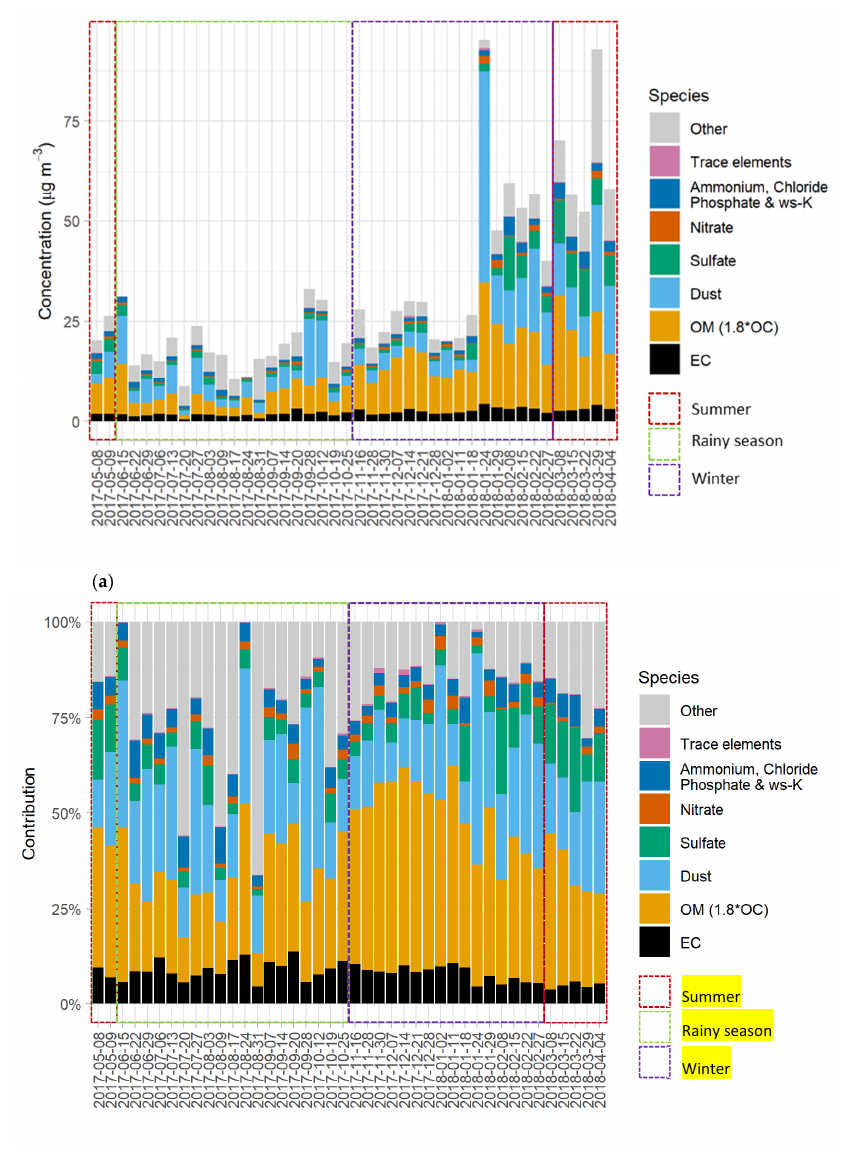
Figure 1. ( a ) Mass reconstructed concentrations of daily coarse particulate matter (PM 10 ) in Yangon, Myanmar. ( b ) Chemical component contributions in daily PM 10 in Yangon, Myanmar.